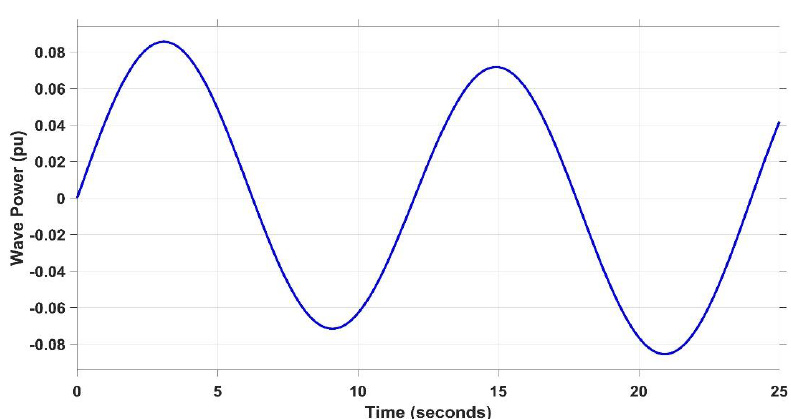
Figure 19. Wave disturbance variation.